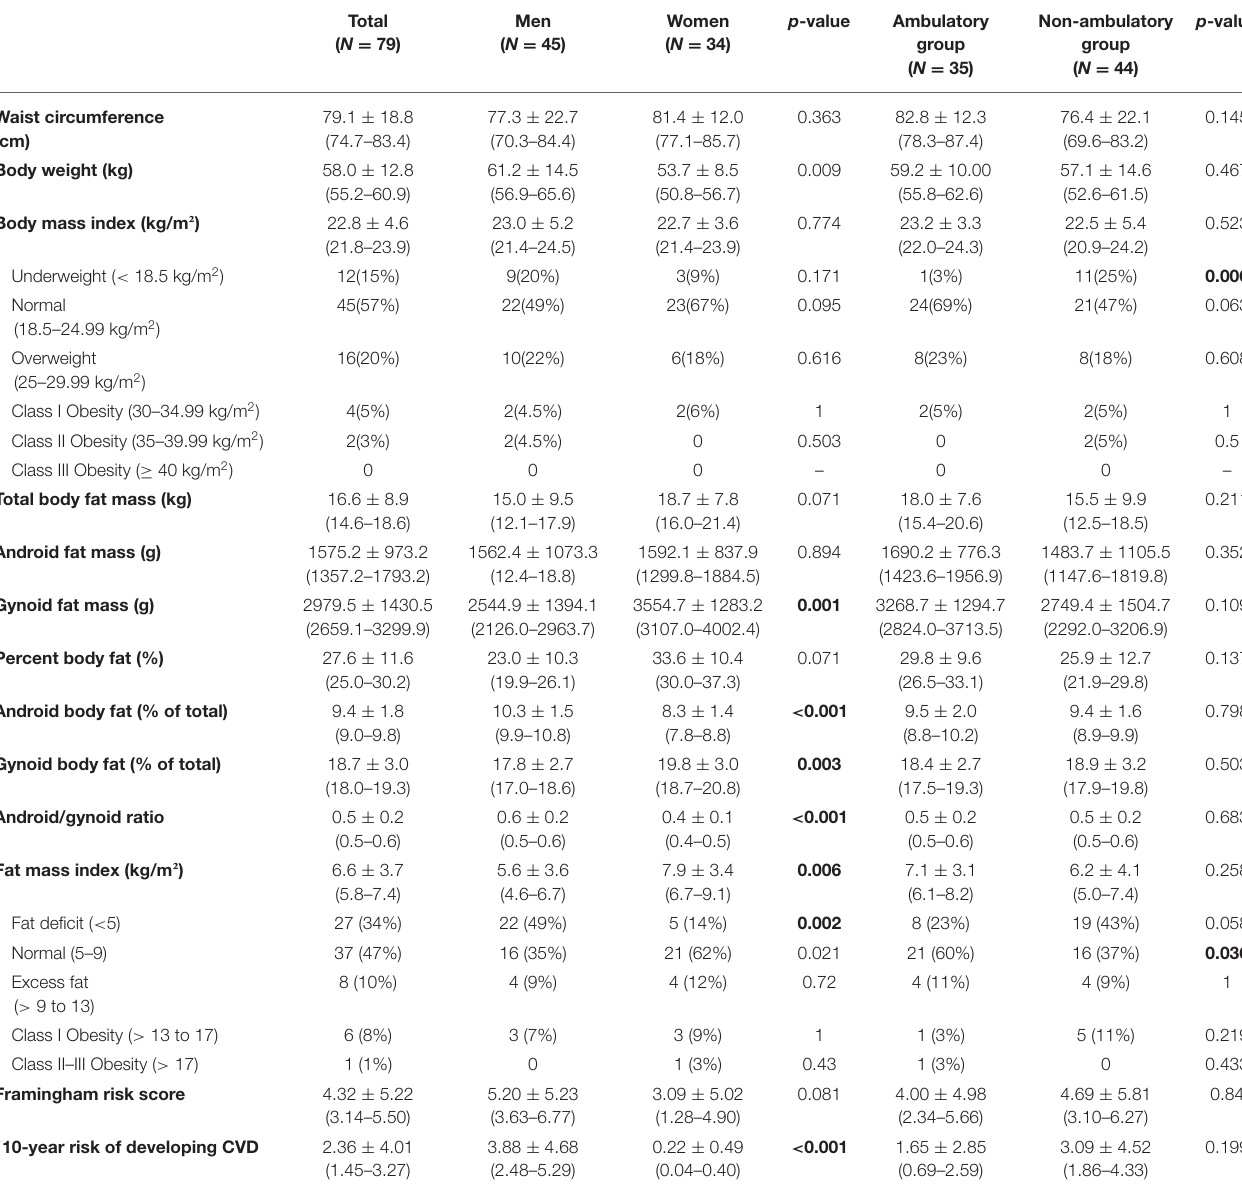
TABLE 2 | Body anthropometry, body composition, Framingham risk score, and 10-year cardiovascular disease risk analysis by sex and ambulatory